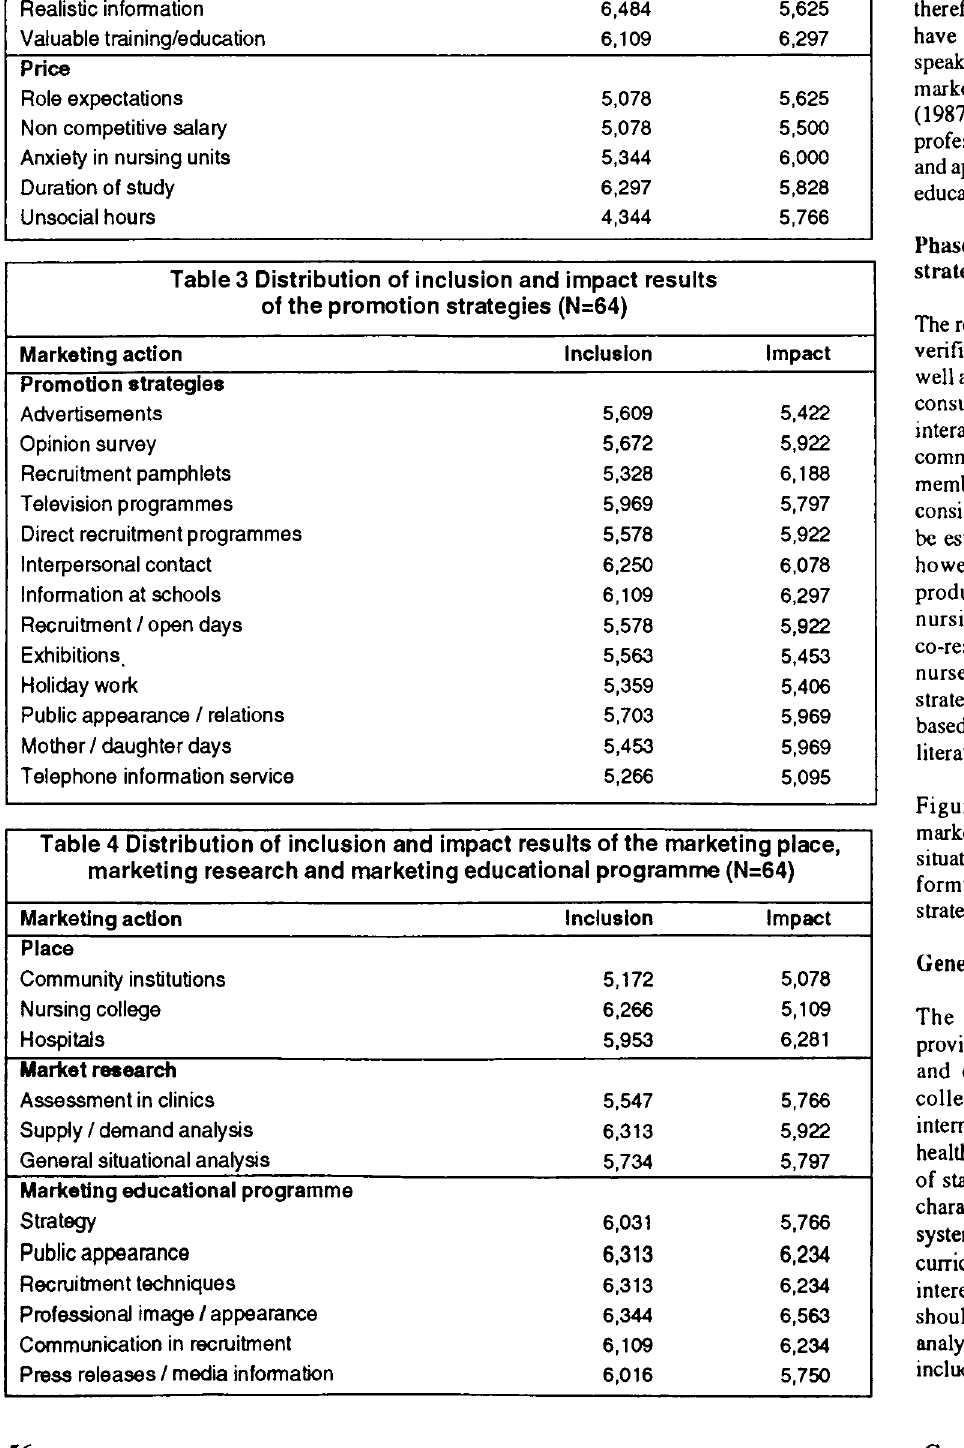
Table 3 Distribution of inclusion and impact results of the promotion strategies (N=64)